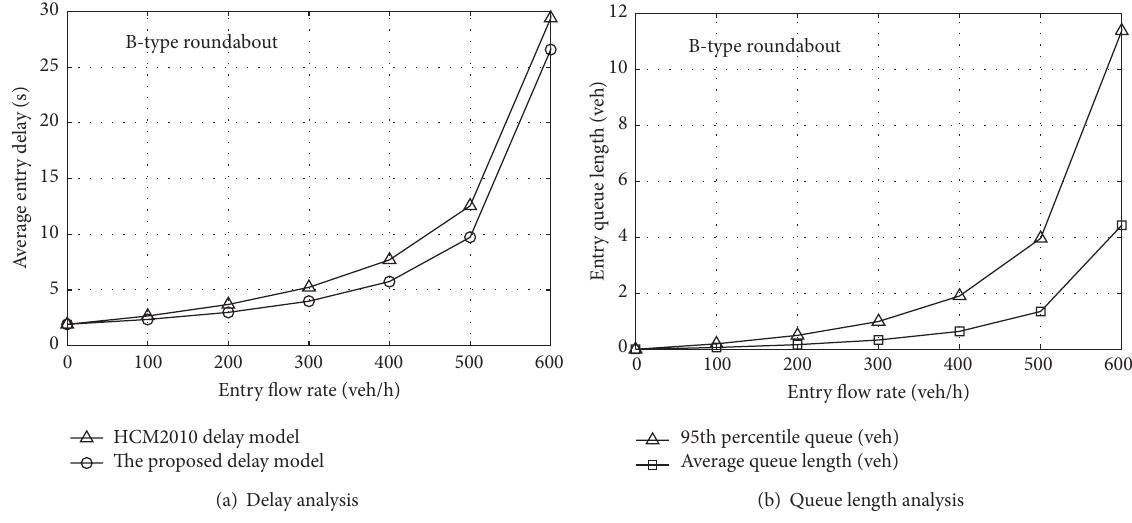
Figure 5: The traffic operations quality of the B-type